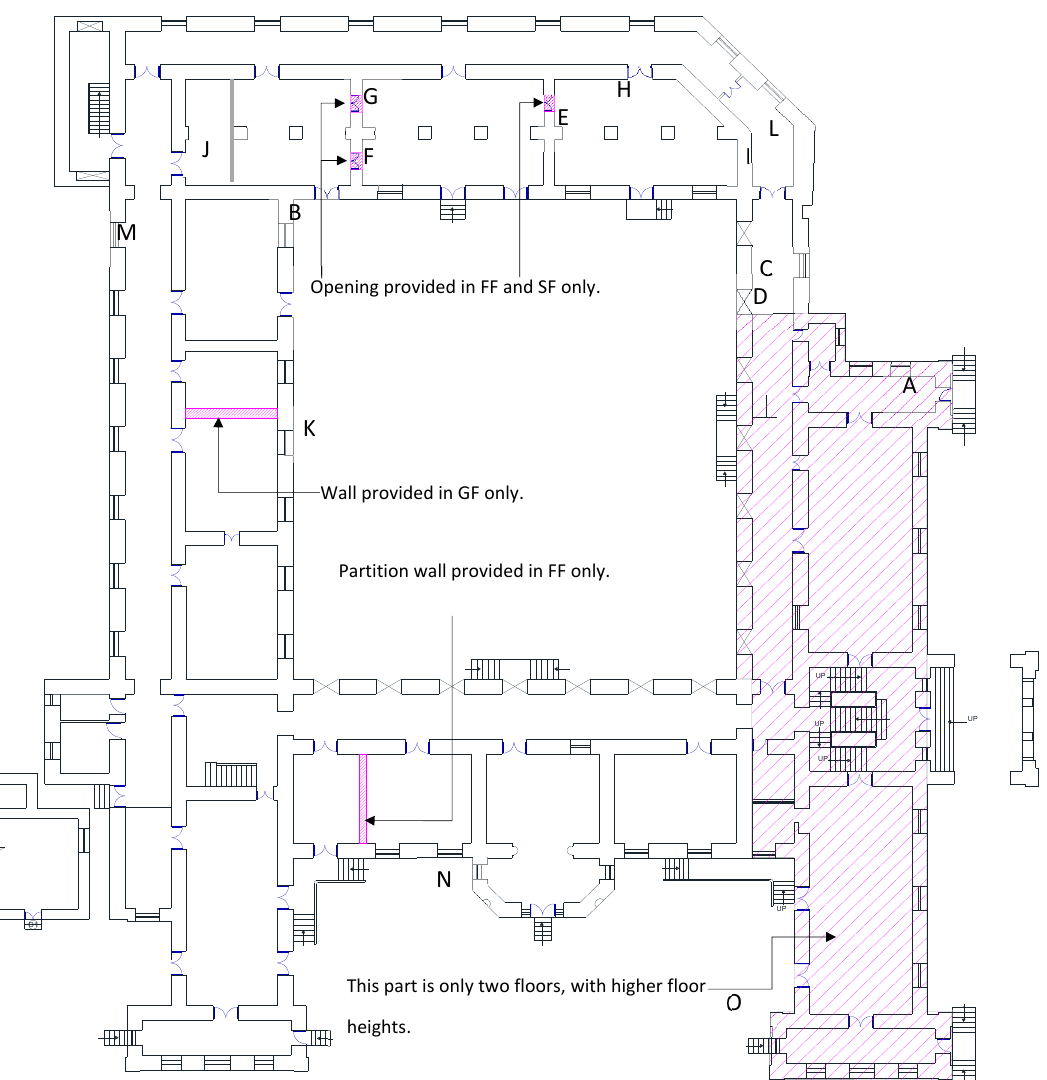
Figure 2. Major damage locations in the monument (capital letters represent the damage mechanisms as shown in Figures 3–6). In the figure, GF, FF, and SF respectively represent the ground floor, first floor, and the second floor.